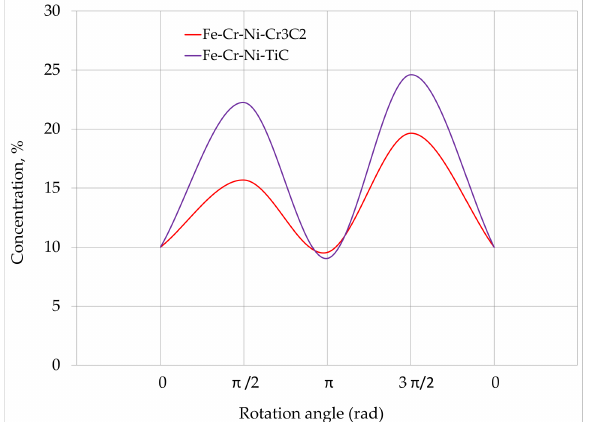
Figure 3. Dependence of the filler concentration in the composite tape along the length of the cylindrical surface of the CBRTB in function of the rotation